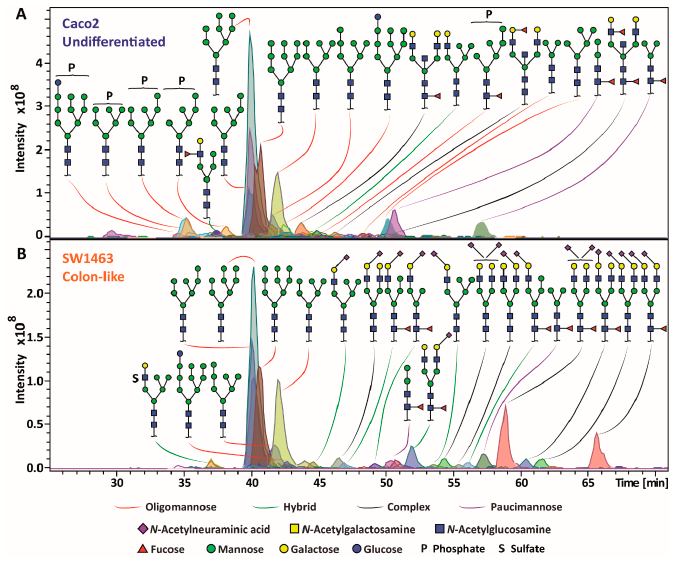
Figure 1. N -glycan profiles of two exemplary colorectal cancer (CRC) cell lines. ( A ) The Caco2 cell line was characterized by phosphorylated high mannose N -glycans as well as N -glycans carrying Lewis antigens. ( B ) Sialylated N -glycans were expressed by the SW1463 cell line. Sialic acid tilted to the left and right indicates α 2-3 linkage and α 2-6 linkage, respectively. Unidentified linkages are indicated with a sialic acid pointing vertically.